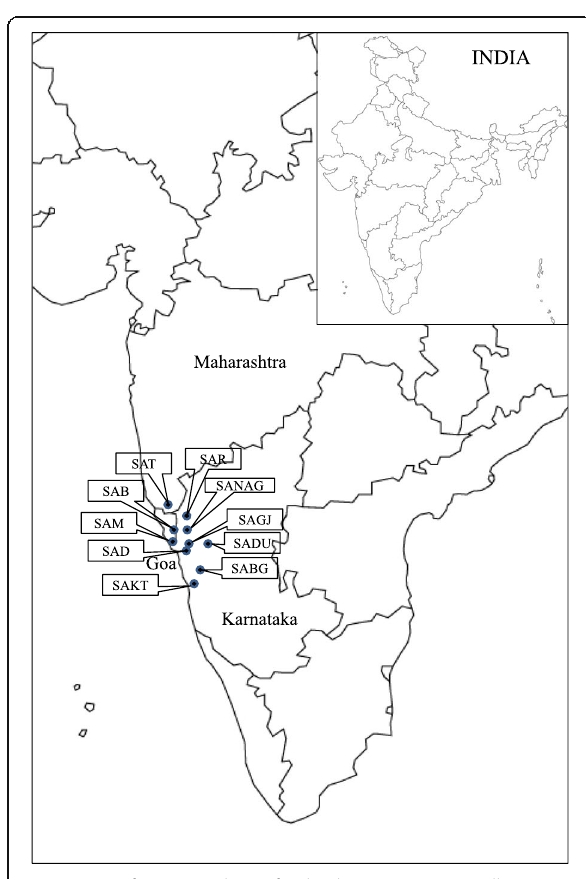
Fig. 1 Map of Western Ghats of India showing S. asoca collection sites. Sampled locations are labelled according to population code (see Table 1)